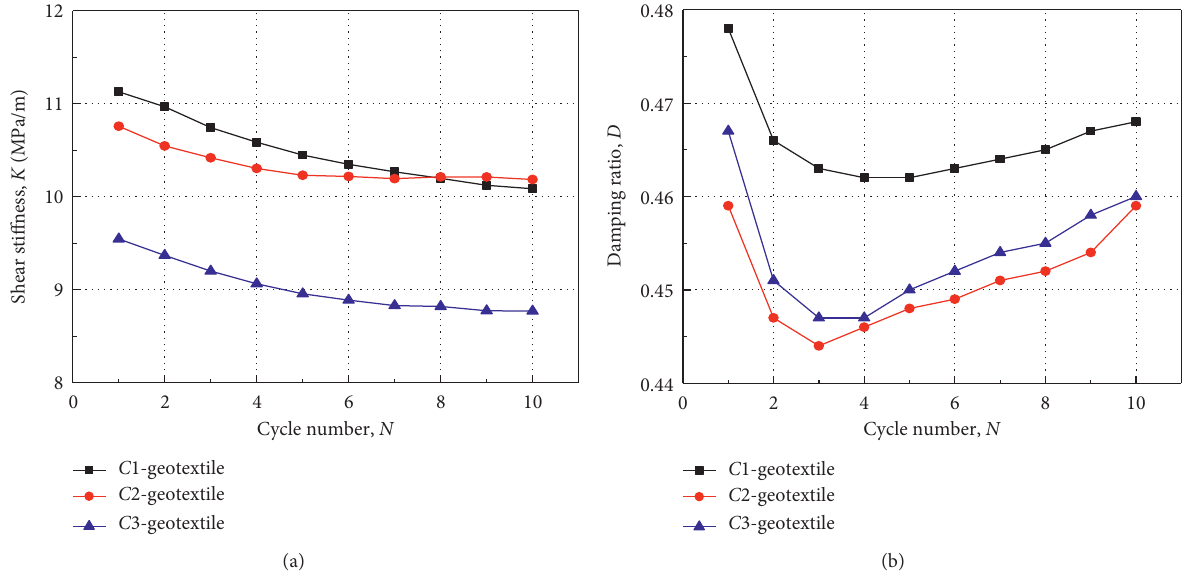
Figure 11: (a) Development of shear stiffness with cycle number and (b) development of damping ratio with cycle number.